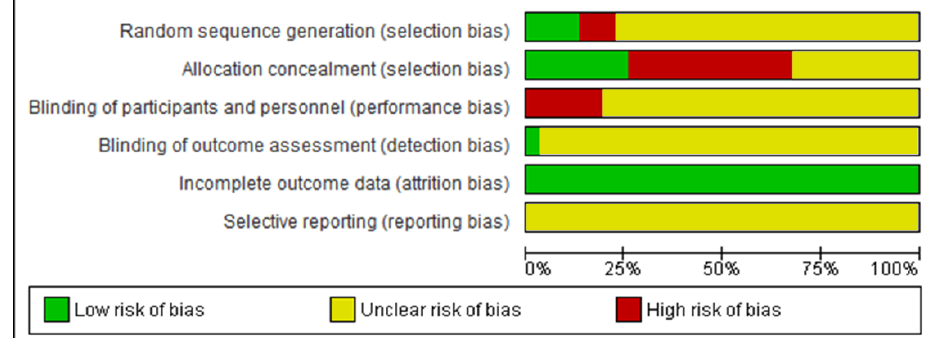
Figure 3. Percentage risk of bias of the studies included in the review.